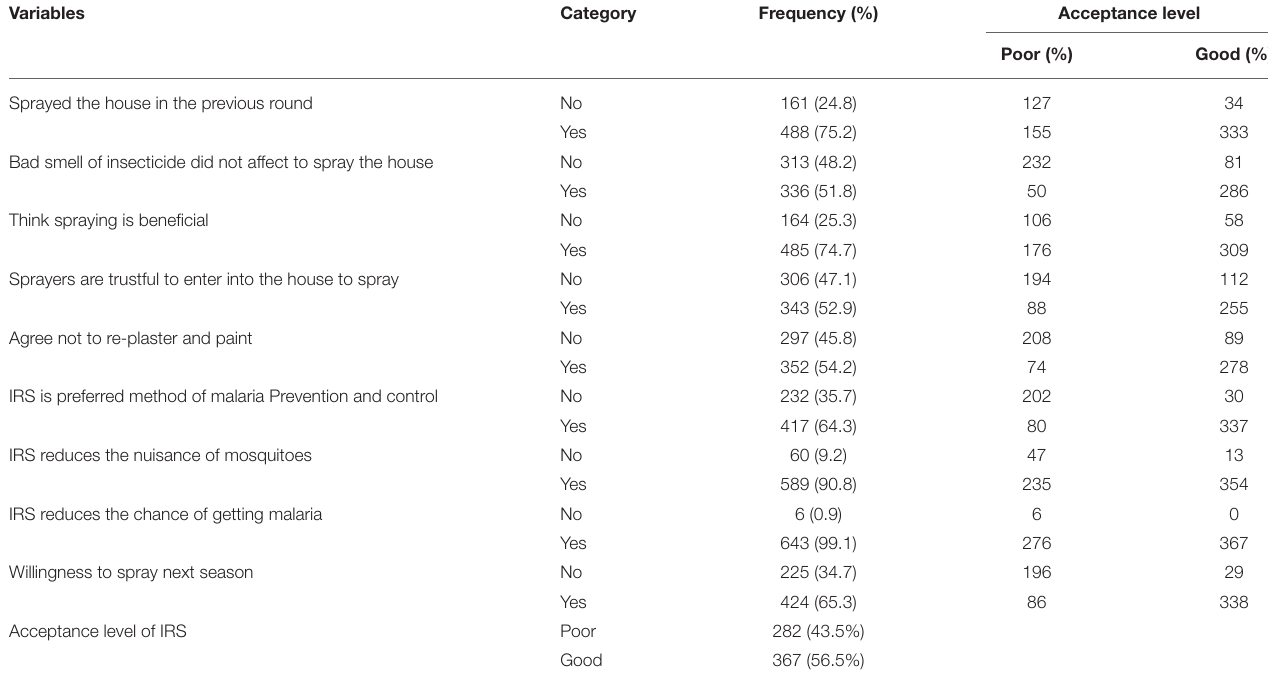
TABLE 4 | IRS acceptance among the study participants in Shewa Robit town, North Eastern Ethiopia, 2021.